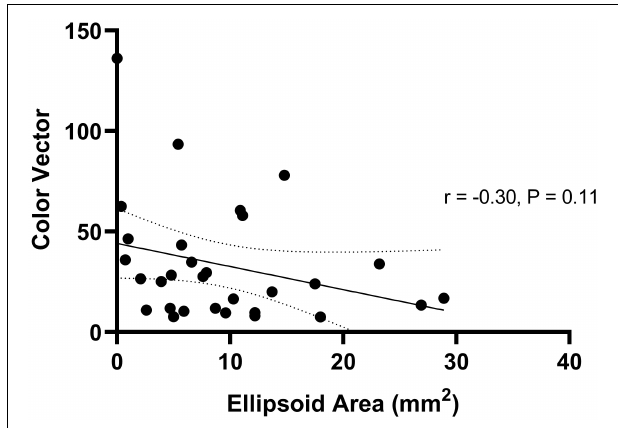
FIGURE 6 | Regression relationship between color vector and ellipsoid area in choroideremia. The color vector represents the degree of color vision loss across the three axes with a higher number representing a greater degree of color loss. The solid line is the regression line and 95% confidence intervals are shown with the dotted